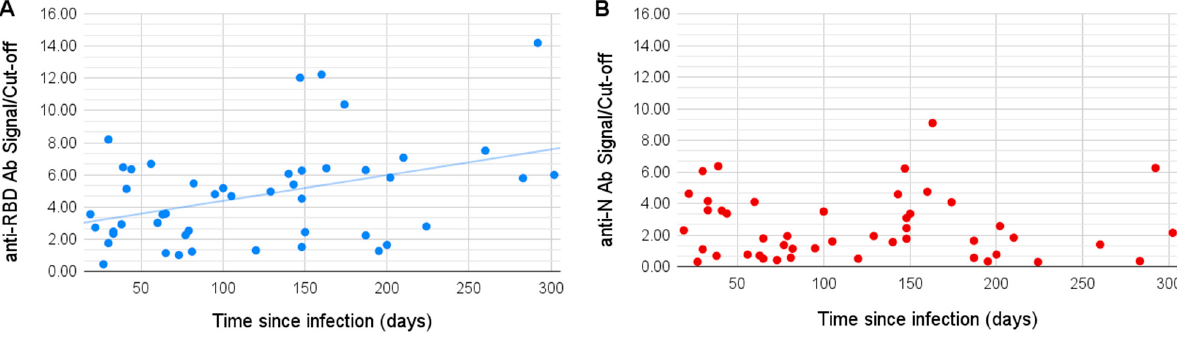
Figure 1. Correlation of time since infection (TSI) with the antibody signal. The S/CO to the anti-RBD ( A ) and anti-N ( B ) antibodies are shown on the vertical axes, TSI is shown on the horizontal axes. The signal to anti-RBD antibodies shows a positive correlation with TSI (R